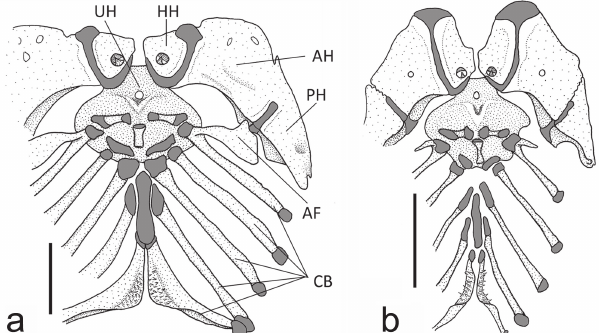
Fig. 7. Lower gill arch and hyoid elements of: a) Oxyropsis wrightiana , MCP 34503; and b) Acestridium martini , MZUSP 74275. AF = accessory flange of first ceratobranchial; AH = anterohyal; CB = ceratobranchial; HH = hypohyal; PH = posterohyal; UH = urohyal. Dorsal view, anterior towards top. Scale bar = 1